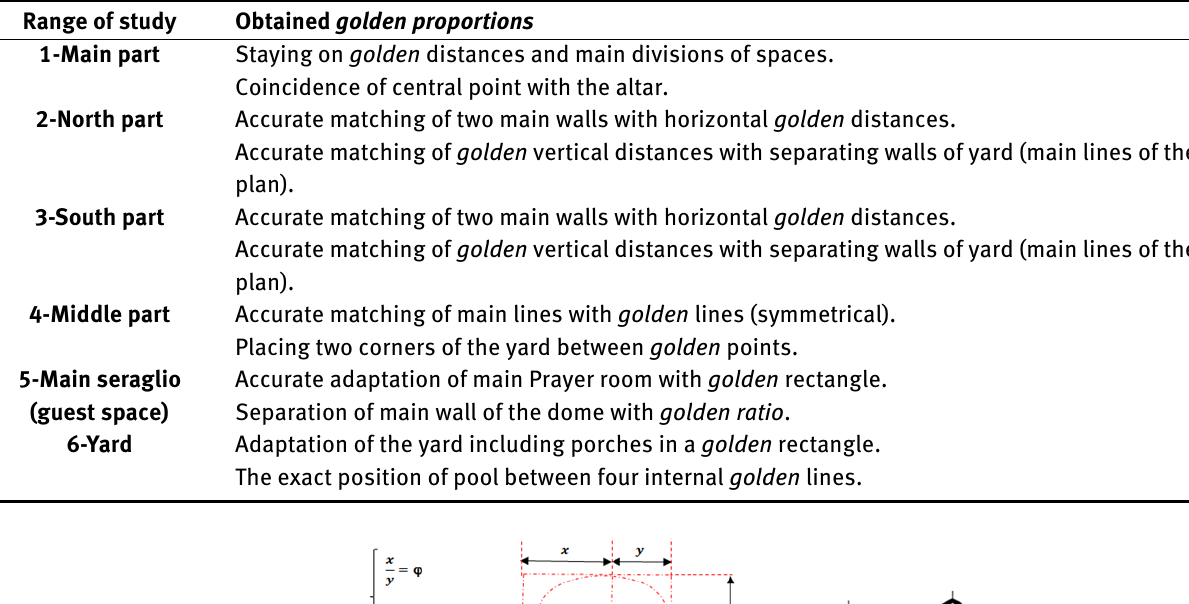
Table 1: Result of plan analysis